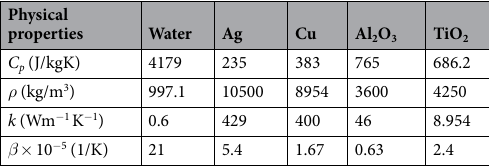
Table 2. Thermo-physical properties of water with Ag, Cu, Al 2 O 3 and TiO 2